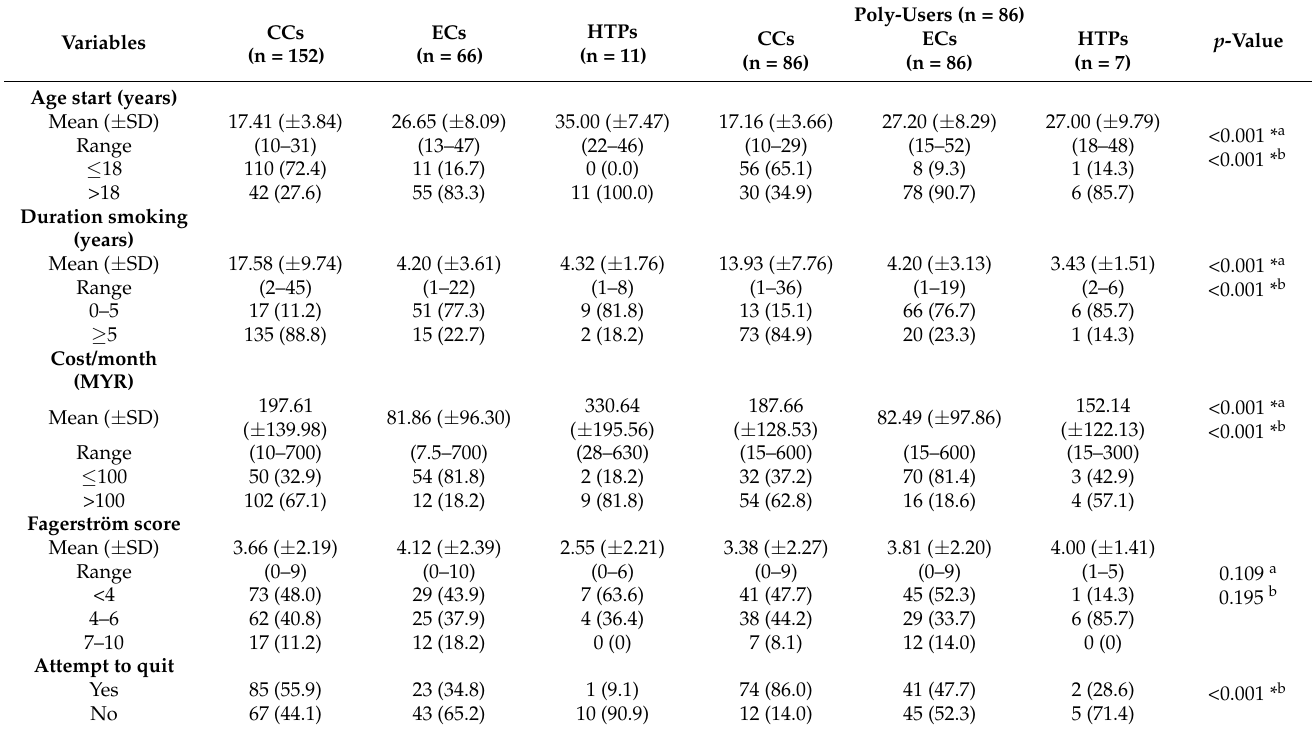
Table 2. Description and comparison between all product